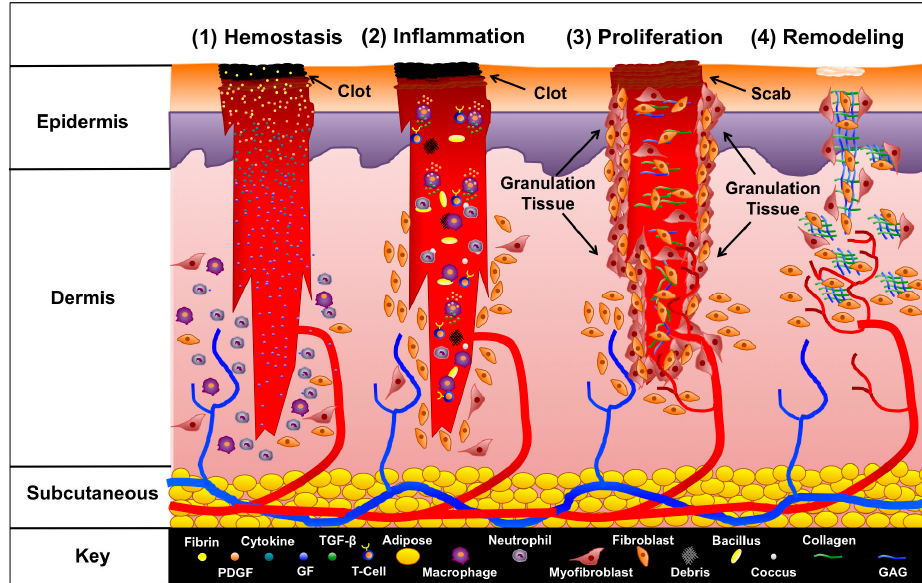
Figure 1. Phases of wound healing. The four phases of wound healing are illustrated. Immediately after a wound forms, hemostasis begins. Platelets form a clot, and are bound together by fibrin. Several cytokines are released, which recruit neutrophils and other leukocytes to the site of injury to start the inflammation phase. Leukocytes begin clearing the wound of bacteria, debris, and other foreign contaminants. T-cells infiltrate the wound and recruit macrophages, which release PDGF and TGF- β to signal fibroblasts and myofibroblasts to start the proliferation phase. Granulation tissue forms, and fibroblasts begin developing new extracellular fibers by producing collagen and GAGs. In addition angiogenesis begins, and new blood is supplied to the site of injury. After proliferation, the final phase, remodeling, occurs in which extracellular fibers align, the wound contracts, and fibroblasts release enzymes to remove damaged extraneous extracellular matrix. Epithelial cells, despite their defining role in coverage, healing, and controlling “crosstalk” with fibroblasts, have been deliberately left out of this schematic representation for the sake of clarity. (PDGF = Platelet-Derived Growth Factor, GF = Growth Factor, GAG =